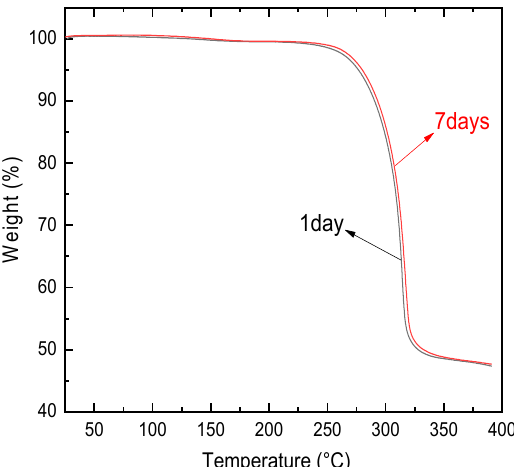
Figure 1. TGA of PVA-LiClO 4 aged for different elapsed times.